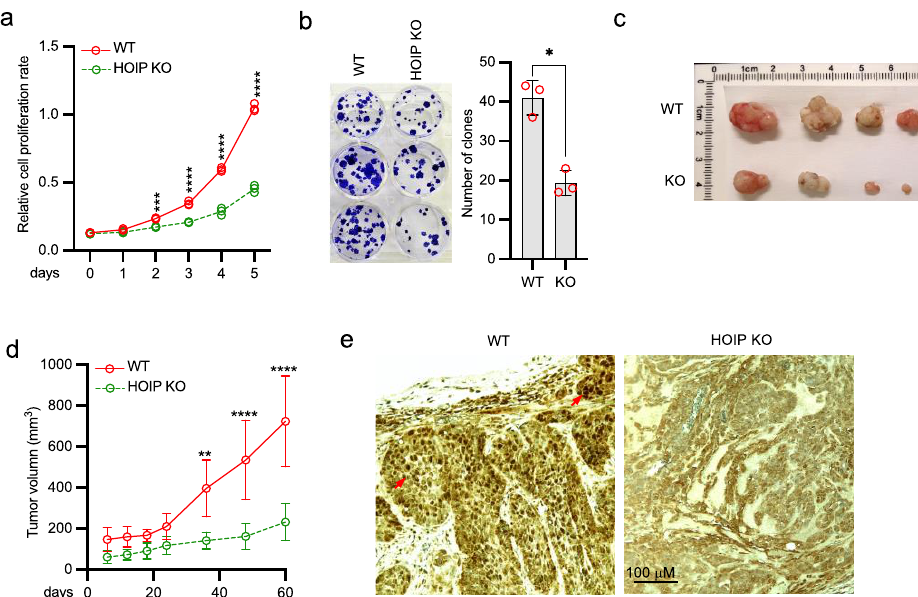
Figure 5. HOIP deficiency inhibits tumor cell proliferation and tumor development. ( a ) The same number of HOIP WT and KO A431 cells were cultured at day 0. Cells were collected at the indicated times for MTT assays to determine cell growth rate. All experiments were biologically repeated three times. Data represent means ± s.d. of three independent experiments. The p -value was calculated by two-way ANOVA followed by Sidak’s multiple comparisons test (*** p < 0.001, **** p < 0.0001). ( b ) HOIP WT and KO A431 cells were cultured to form colonies. All experiments were biologically repeated three times. Data represent means ± s.d. of three independent experiments. The p value was calculated (two-tailed Student’s t-test) by comparison with wild type cells (* p < 0.05). ( c ) Representative figure of tumors from nude mice xenografted with HOIP WT or KO A431 cells. ( d ) Growth rate of tumors from nude mice xenografted with HOIP WT or KO A431 cells. The p -value was calculated by two-way ANOVA followed by Sidak ’ s multiple comparisons test (** p < 0.01, **** p < 0.0001). ( e ) Representative IHC images of Ki-67 staining with hematoxylin counterstain in HOIP WT and KO tumors. Arrows indicate the high intensity staining of Ki-67 in the nuclei.